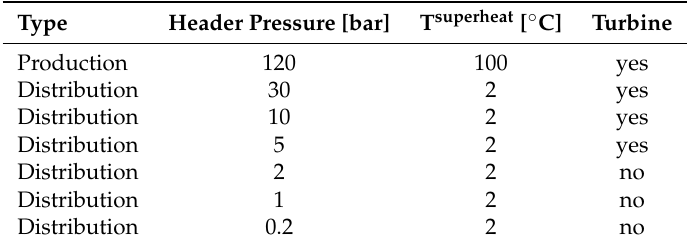
Table A12. Parameters for steam network.